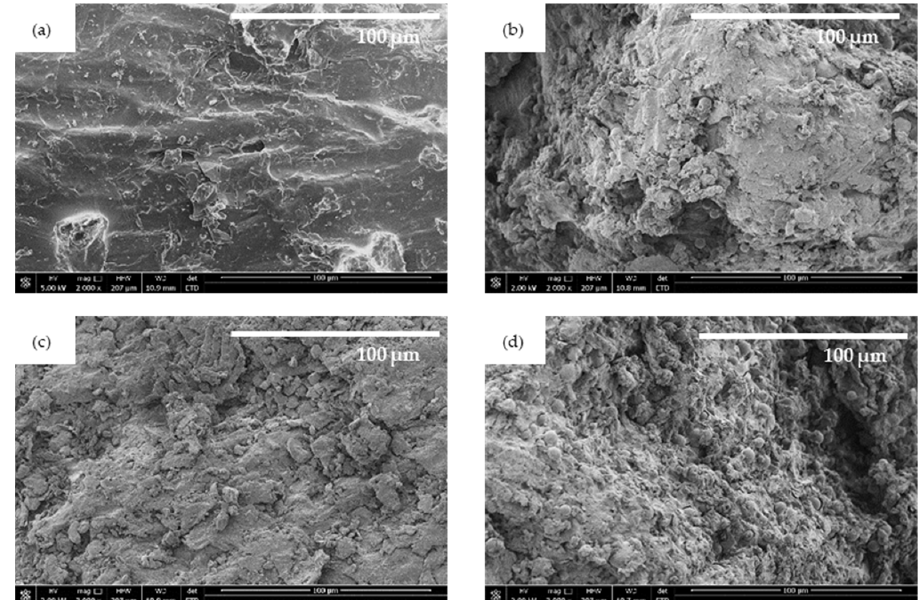
Figure 1. The external surface of ( a ) unmodified walnut shell filler, and walnut shell filler modified with ( b ) perlite, ( c ) montmorillonite, and ( d ) halloysite.